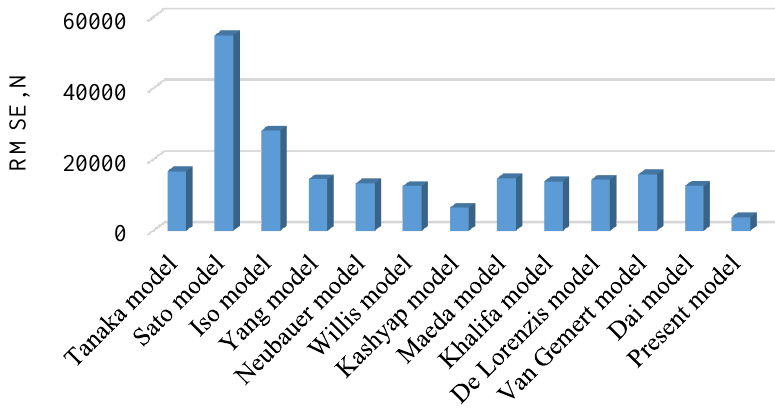
Figure 4. Comparison of the GEP model with existing methods in the prediction of the debonding force for the training data.